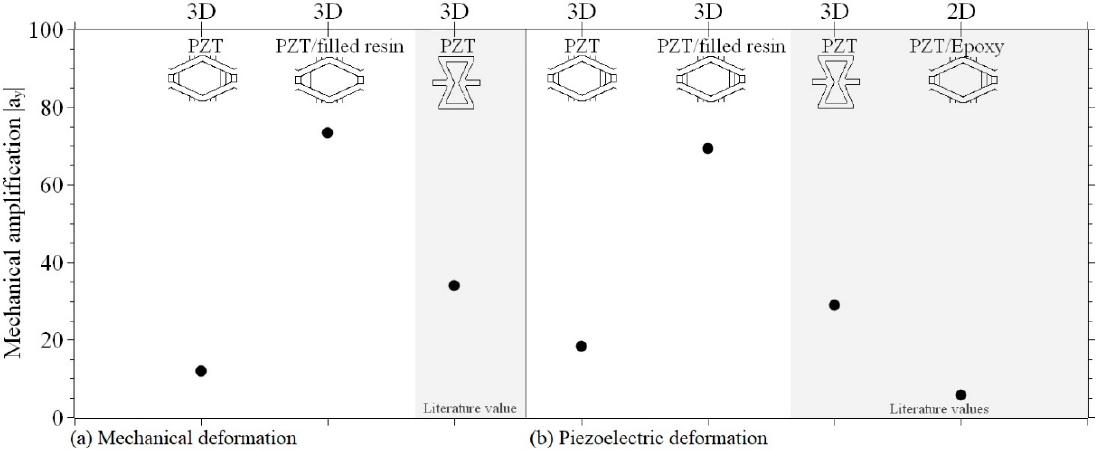
Figure 4. Mechanical amplification as a ratio of the deformation of cellular structures and bulk material as a function of mechanical ( a ) and piezoelectric ( b ) excitation.